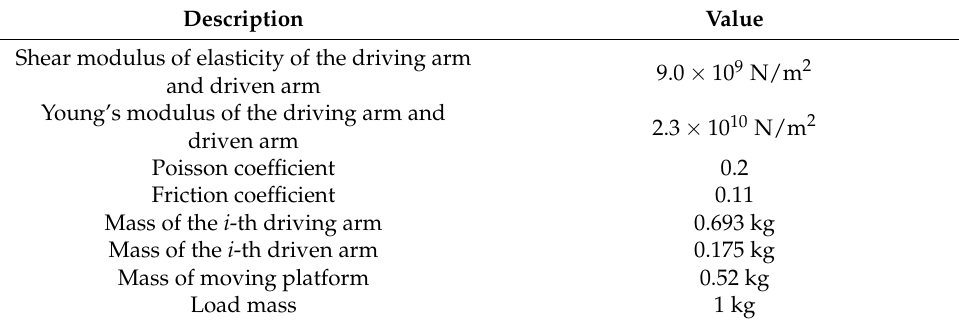
Table 2. Dynamic parameters of the Delta